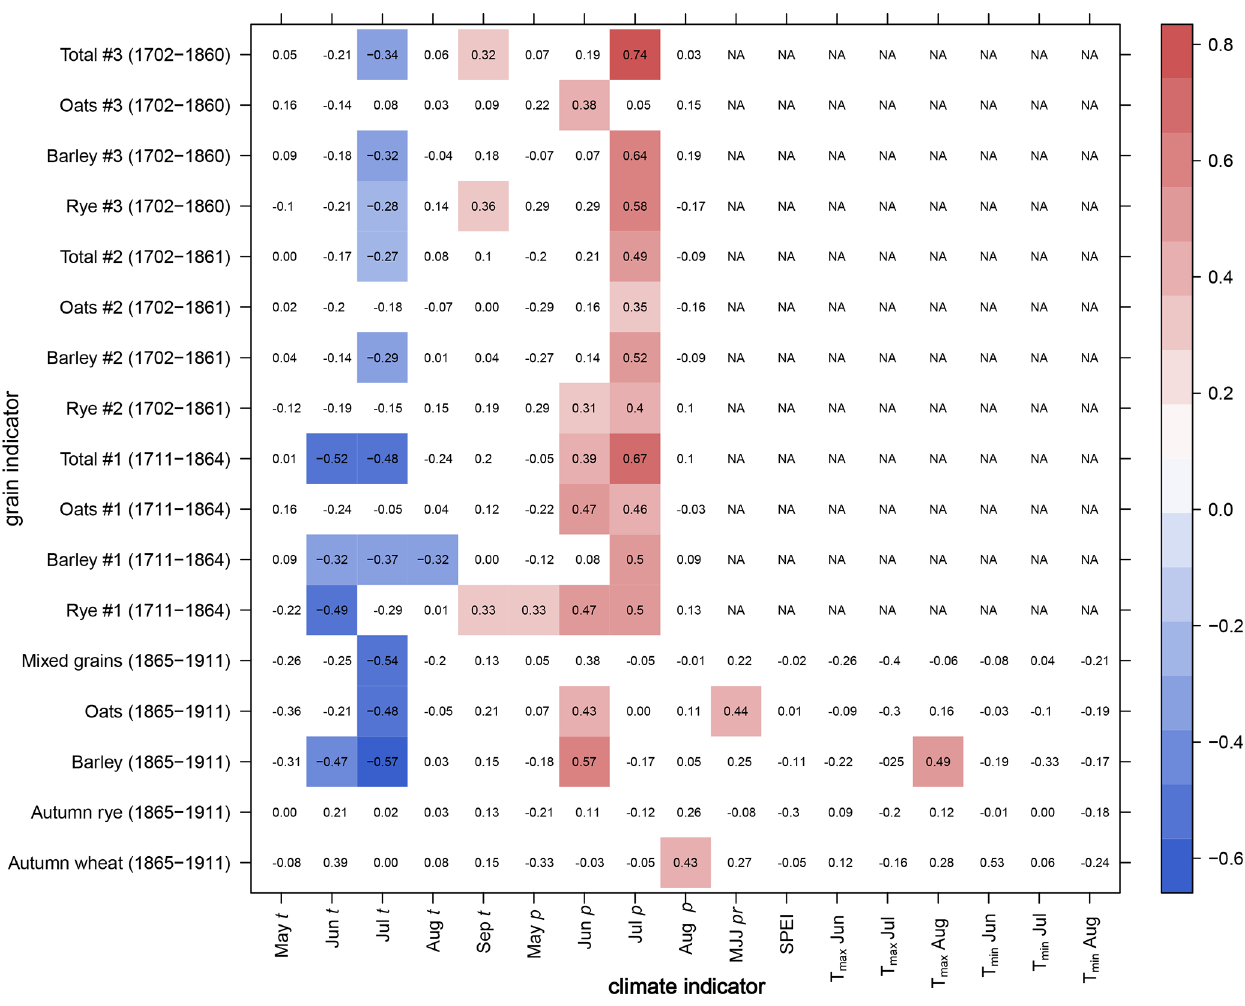
Figure 13. Correlations of grain series vs. climate indicators ca. 1702–1865 and 1865–1911 during relatively wet years. Note: only sta- tistically significant ( p ≤ 0 . 05) correlations are colored. Clusters are signified by number. Sources: HDSA, SCB (2021), Tidblom (1876), Seftigen et al. (2017, 2020), SMHI (2021), and the homogenized monthly temperature series (Appendix